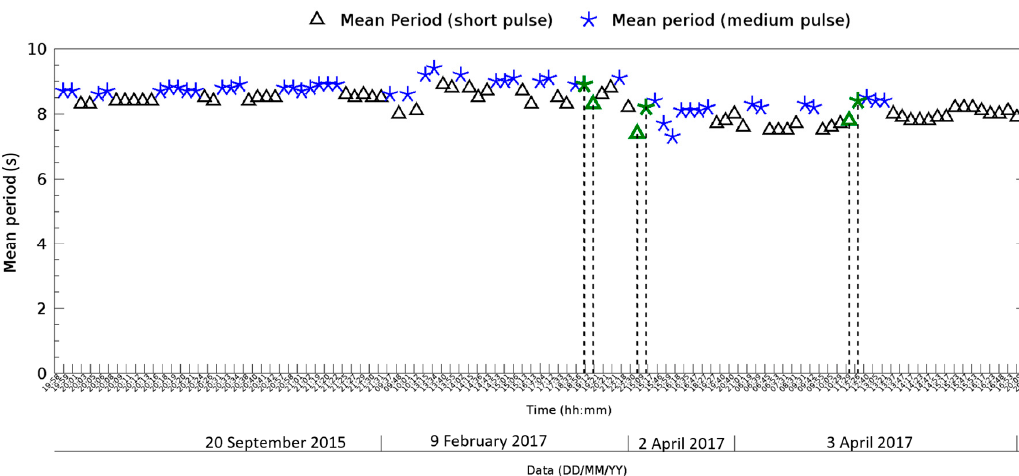
Figure 9. Mean Period of dominant waves obtained by analyzing radar data in medium (blue star) and short (black triangle) pulse mode configurations. The green symbols and the vertical dashed lines indicate the measurements values obtained from the 2D directional spectra used for the qualitative comparison.